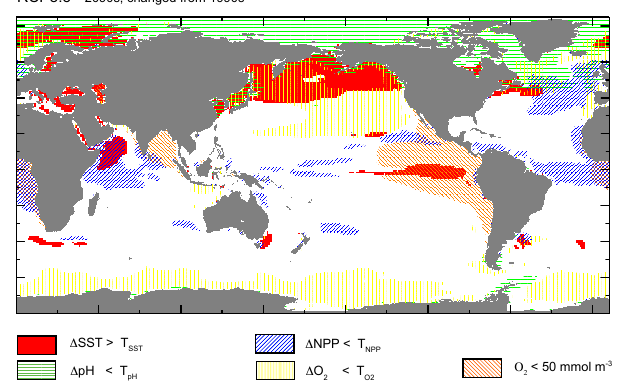
Fig. 14. Change in multiple stressor intensity (defined as the change in the magnitude of the considered variable) in 2090–2099 relative to 1990–1999 under the RCP8.5 scenario. The thresholds (T SST , T pH , T O , T NPP ) for SST, surface pH, subsurface O 2 and integrated 2 NPP have been defined as the sum of the global mean change in 2090–2999 and of the model-mean spatial standard deviation, such that ∼ 1 / 3 of the global ocean with the largest changes is depicted for each of the stressor. Red indicates where sea surface warm- ing exceeds its threshold T SST ( + 3.64 ◦ C), hatched green indicates where surface pH decreases by more than T pH ( − 0.36pH unit), hatched yellow indicates where subsurface (200–600m) oxygen concentrations decrease by more than T O ( − 19.9mmolm − 3 ) , and 2 hatched blue indicates where vertically integrated NPP decreases by more than T NPP ( − 79.8gCm − 2 yr − 1 ) . When the simulated model- mean change is not robust (see text for the definition of the robust- ness index), no color is shown. In addition, hatched orange indicates present-day low-oxygen ( < 50mmolm − 3 ) subsurface (200–600m)